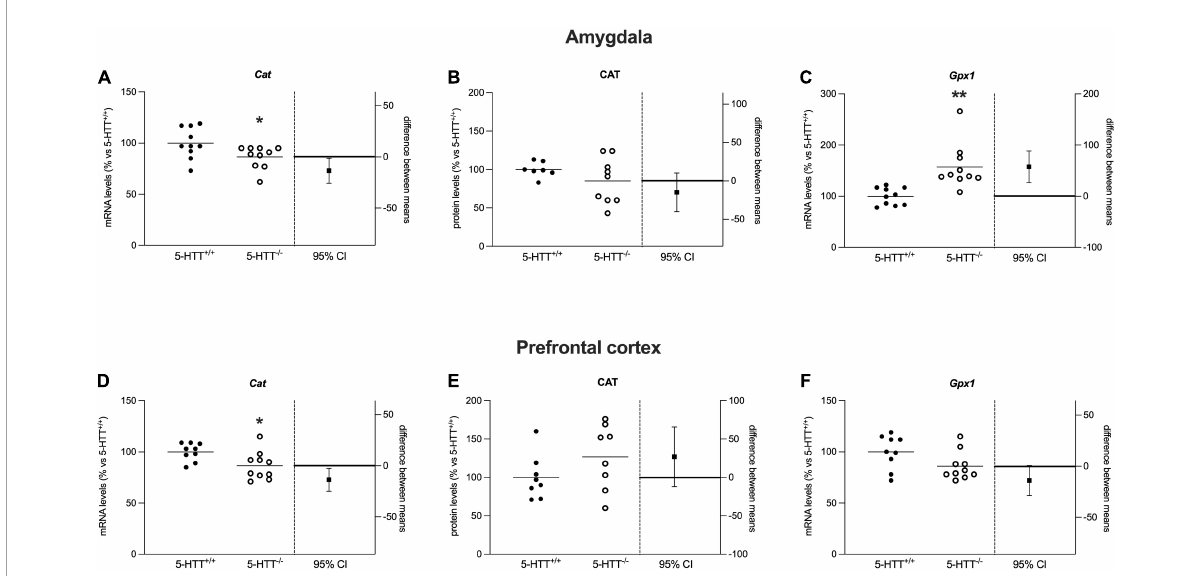
FIGURE6 Analysis of Cat mRNA and protein levels and Gpx-1 mRNA levels in the amygdala (A–C) and in the prefrontal cortex (D–F) of 5-HTT + / + and 5-HTT − / − rats. The results are represented as Gardner–Altman plots. The black square shows the difference between the two means, and the error bar shows the 95% confidence interval of that difference. The data are expressed as a percentage of 5-HTT + / + (set at 100%) of 6 to 10 independent determinations. * p < 0.05, ** p < 0.01 vs. 5-HTT + / + (Unpaired t -test).